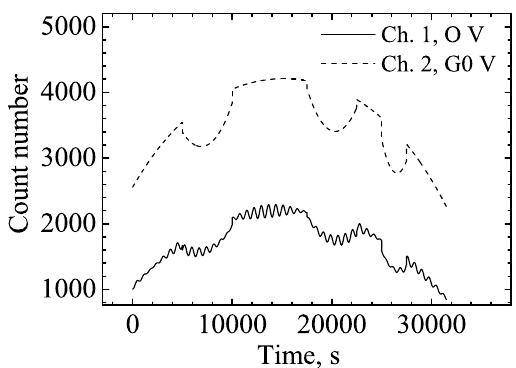
Fig. 6. Synthetic observations of a vari- able (Channel 1) and a comparison (Channel 2) stars, when the atmospheric extinction is calculated for the atmospheric transmittance curves shown in Figure 2 with additional ex- tinction values due to clouds, which are de- fined by polynomials given in the